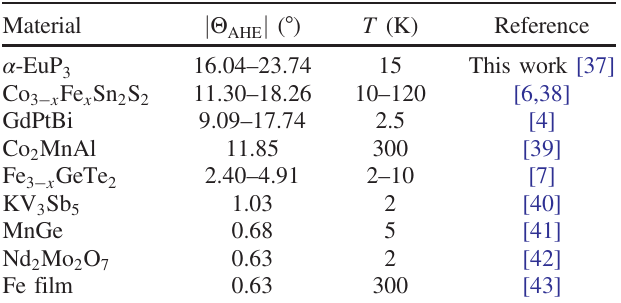
TABLE I. Magnitudes of the anomalous Hall angle ( j Θ j tan − 1 ð σ HA = σ Þj ) and measurement temperatures of various AHE